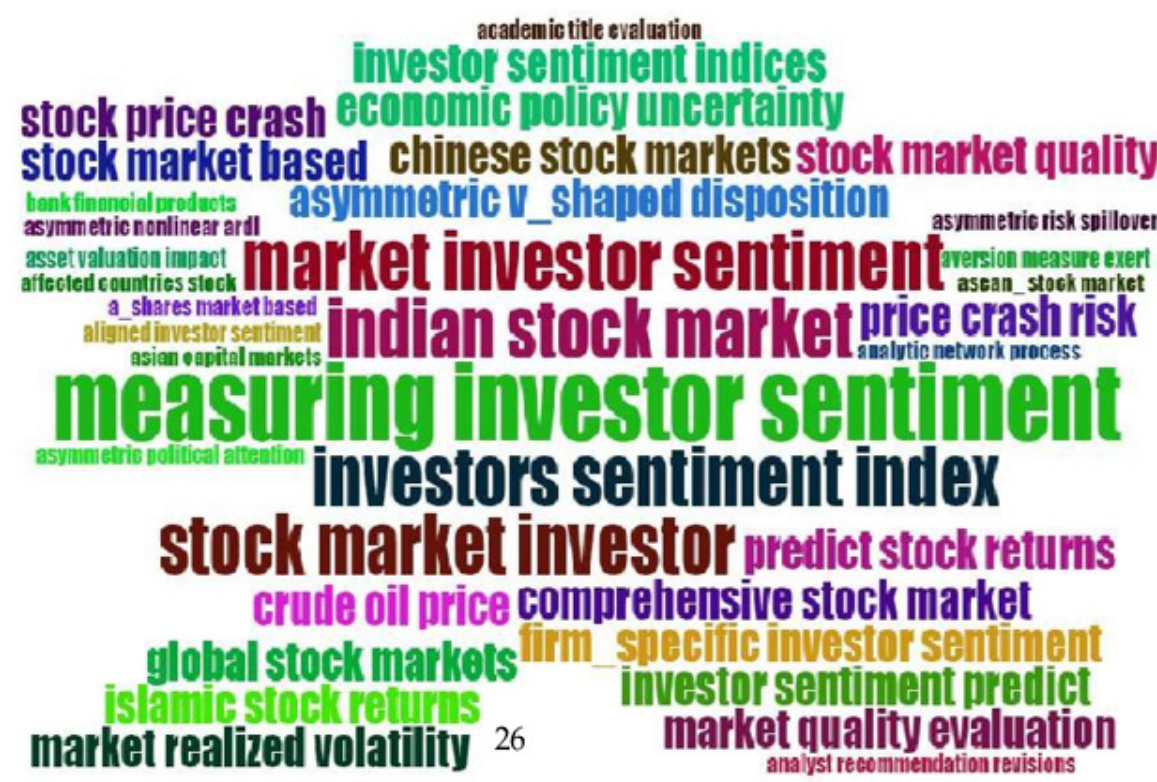
Figure 9. Most used terms used in titles.